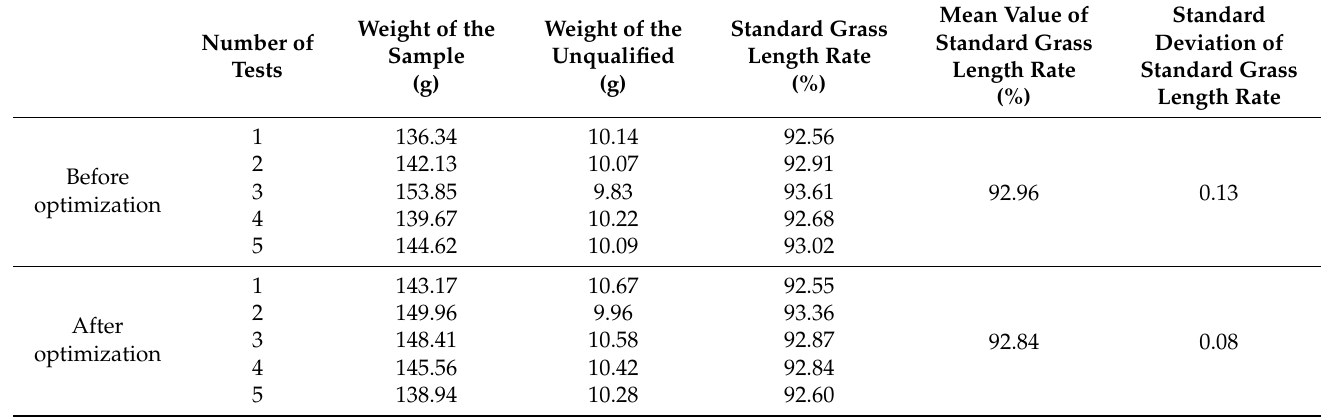
Table 3. Experimental data and analysis of standard grass length